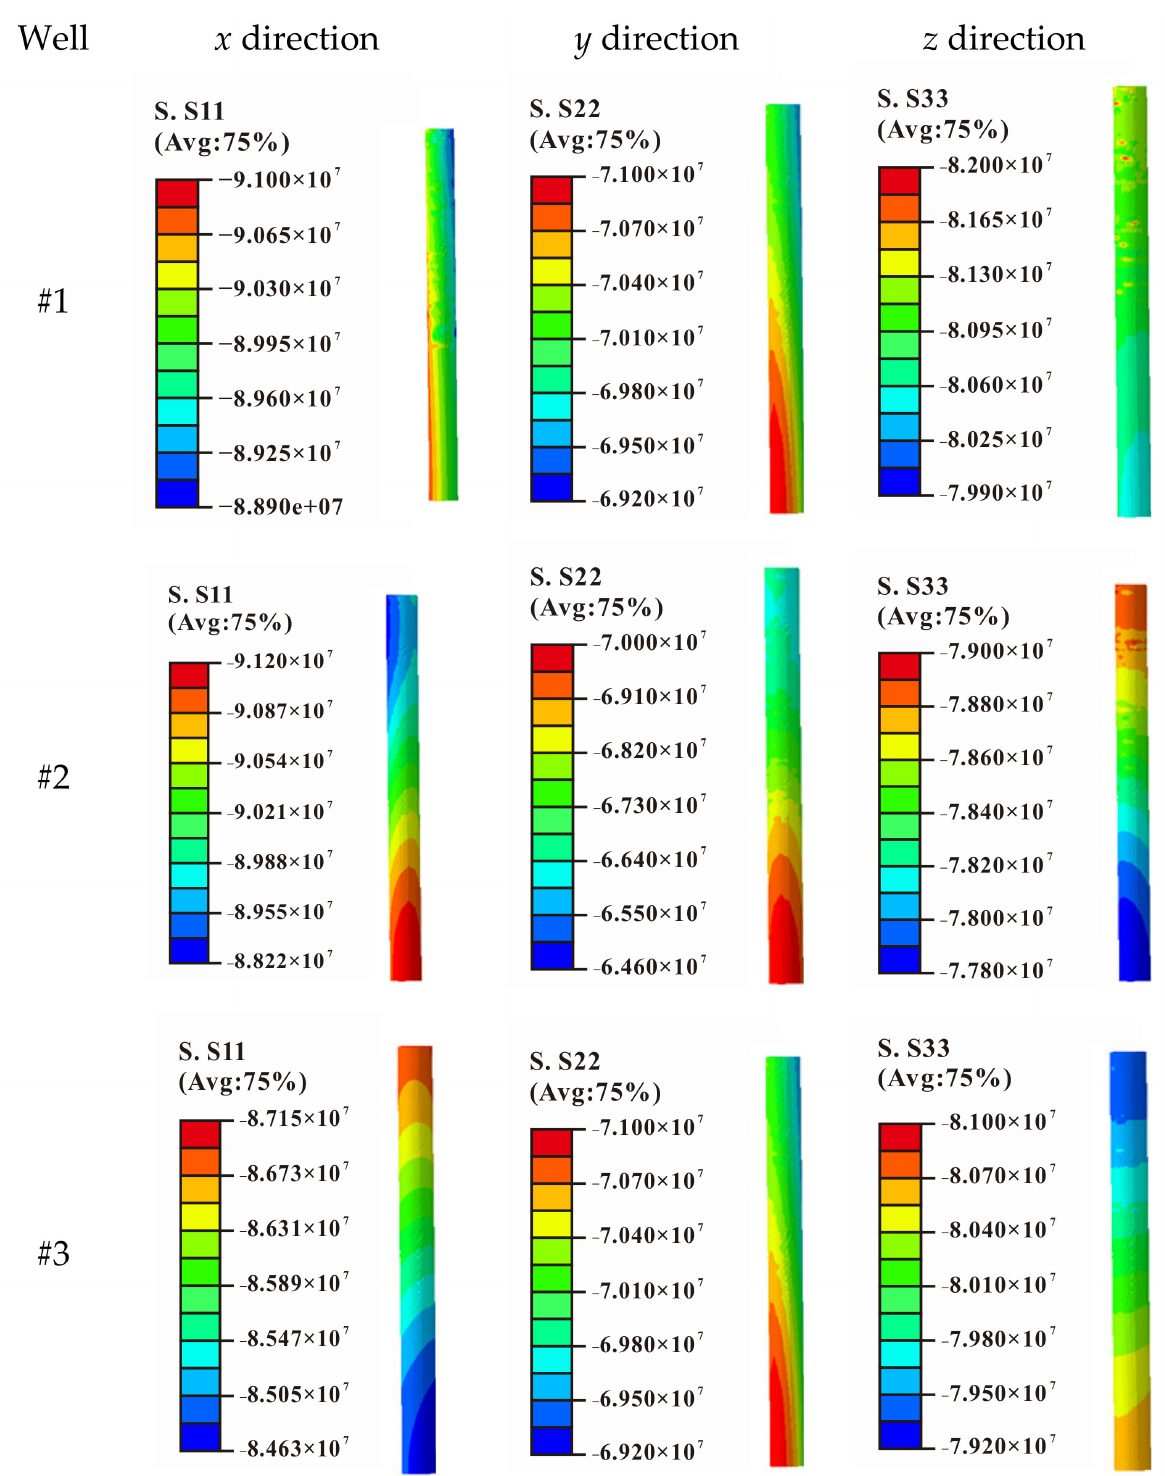
Figure 9. Stress distribution of the well zone after crustal stress